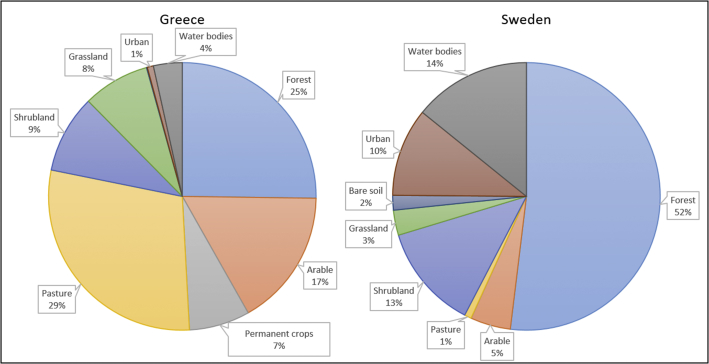
Land cover in Greece and Sweden according to Faragó et al. (2019).